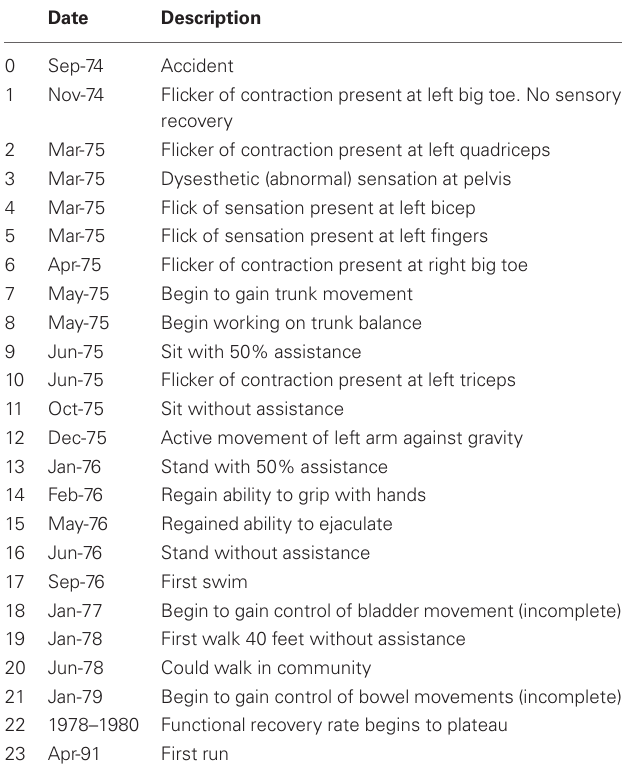
Table 1 | Detailed timeline of the patient’s